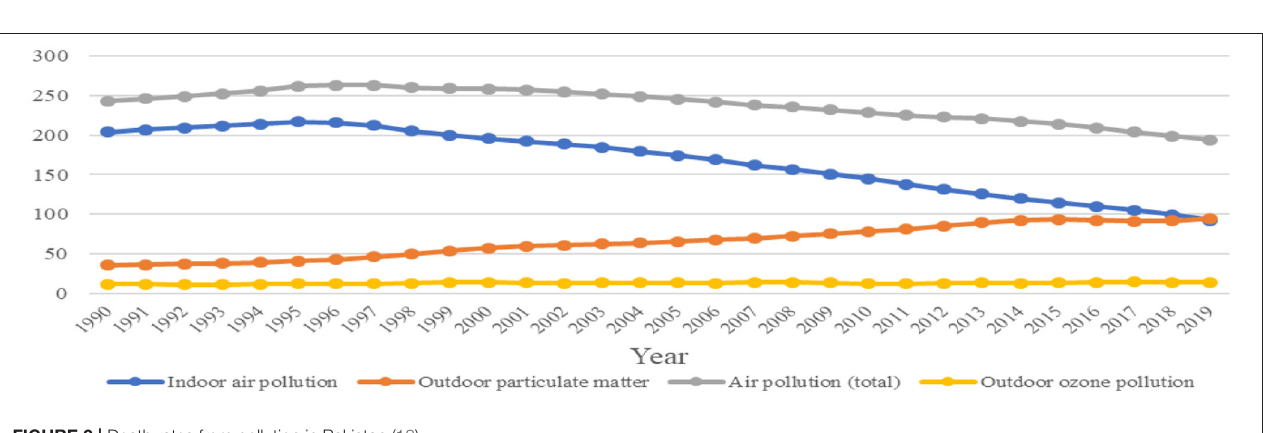
FIGURE 1 | Cost of health damage from PM 2.5 exposure in 2019 by region, % equivalent of GDP (PPP). Source: World Bank (14). EAP, East Asia and Pacific; ECA, Europe and Central Asia; LAC, Latin America and Caribbean; MNA, Middle East and North Africa, NA, North America; SA, South Asia; SSA, Sub-Saharan Africa. Numbers may not add up due to rounding.